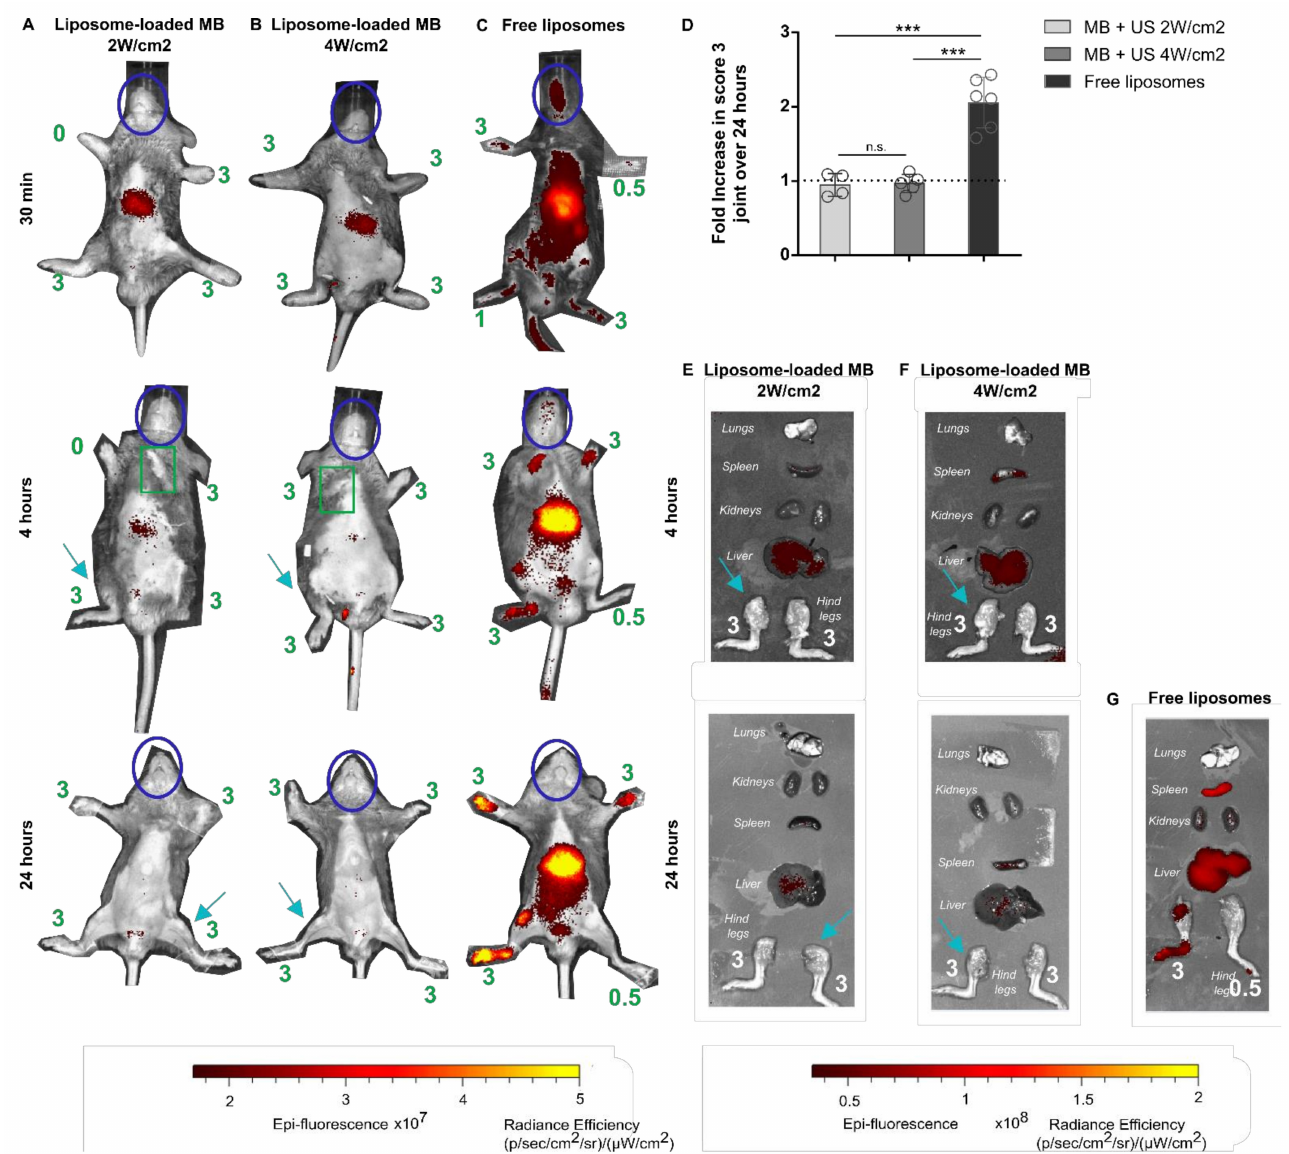
Figure 5. Representative whole body fluorescent images to illustrate the biodistribution of fluores- cently labelled liposomes. Representative whole body ( A – C ) and ex vivo organ fluorescence images ( E – G ) of DiR liposomes after injection of liposome-loaded microbubbles ( A , B , E , F ) or the same dose of liposomes ( C , G ). One knee joint with a CIA score 3 of microbubble-injected mice were treated with therapeutic ultrasound of 1 MHz with an acoustic pressure of 2 W/cm 2 ( A , E ) or 4 W/cm 2 ( B , F ) and is indicated by a blue arrow. Whole body fluorescence images were taken at 30 min, 4 and 24 h after liposome or microbubble injection. n = 2 replicates for each ultrasound condition and n = 3 for the liposome only condition. The CIA score of the front paws and ankles of the mice is displayed next to each limb. A green square is added as a visual aid to locate the front paw. The ‘throat-neck’ area was used to estimate the liposomes in circulation and is indicated by a blue circle. ( D ) Overview of fluorescence increase over 24 h after injection of the liposome-loaded microbubbles in CIA score 3 US-treated knees either exposed to a therapeutic ultrasound pulse of 2 or 4 W/cm 2 (each dot represents a treated knee), and score 3 joints (including knees, front paws, and ankles (each dot represents a score 3 joint)) in mice that were injected the exact same amount of free liposomes. Different treatment groups were compared via one-way ANOVA, with Tukey’s correction for multiple testing, asterisks: *** respectively represent p <